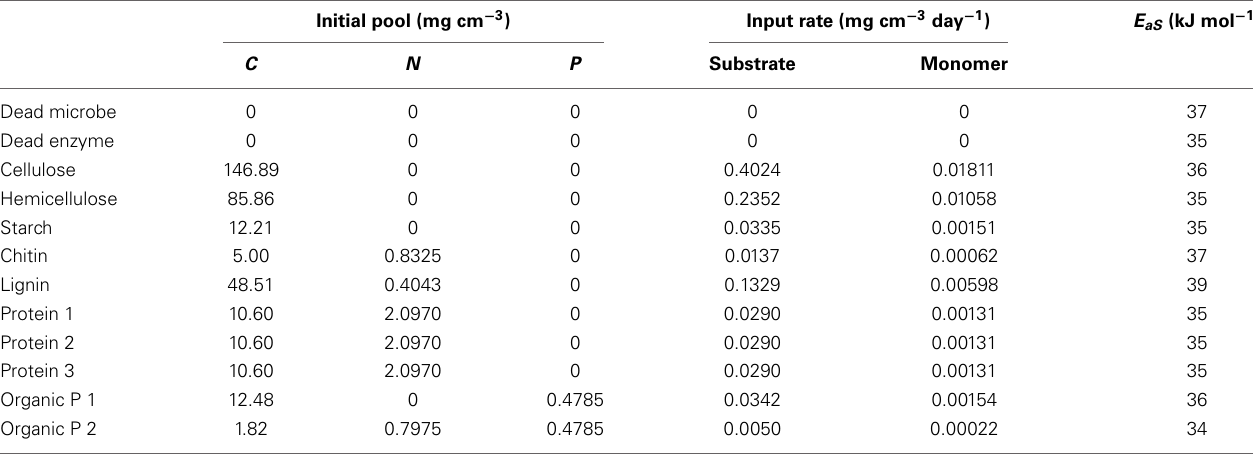
Table 2 | Initial pool sizes, input rates, and activation energies ( E aS ) for decay of chemical substrates in the DEMENT model.